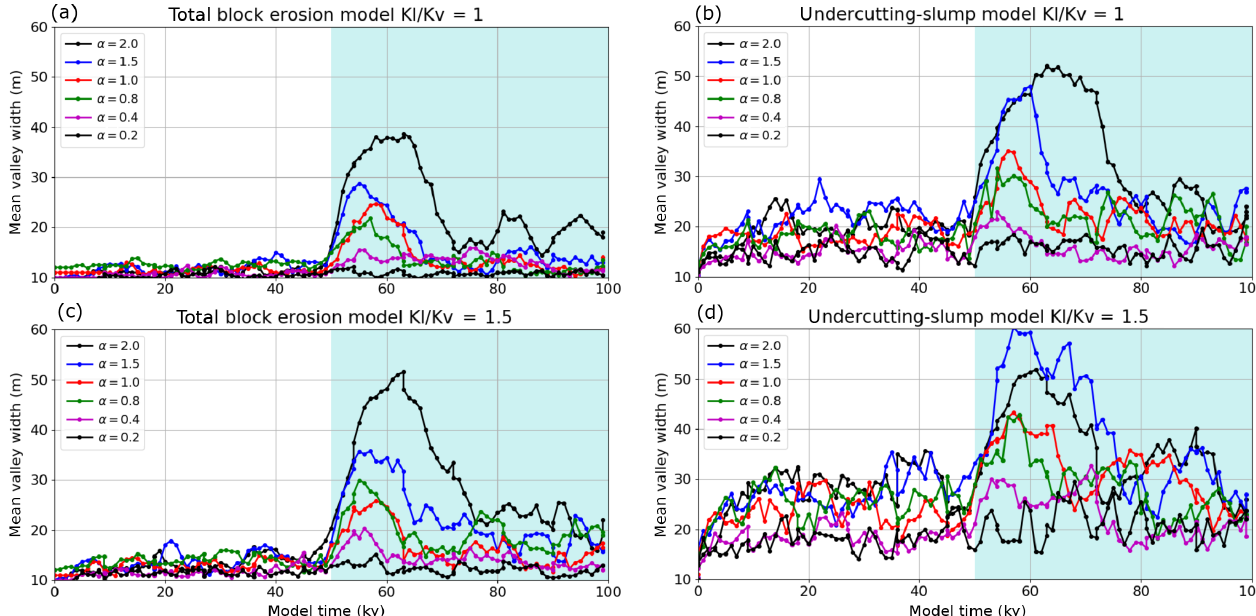
Figure 11. Mean valley width for the upper half of the model domain over the duration of additional sediment flux model run for total block erosion and undercutting-slump models with K l /K v ratios of 1 and 1.5. Light blue shading indicates the duration of increased sediment flux.